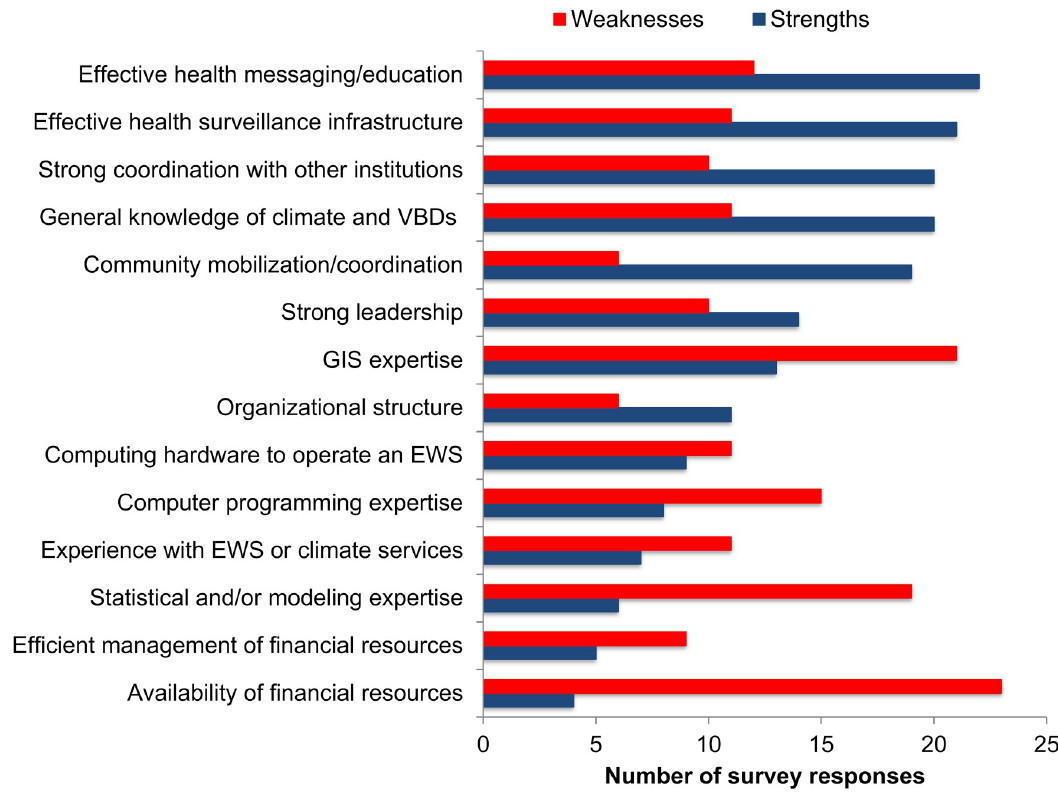
Fig 3. Perceptions of the strengths and weaknesses of the health sector with respect to the capacity to implement an early warning system for arboviral diseases. EWS = early warning system, GIS = geographic information system, VBDs = vector borne diseases. Results shown as the number of health sector survey respondents (n =